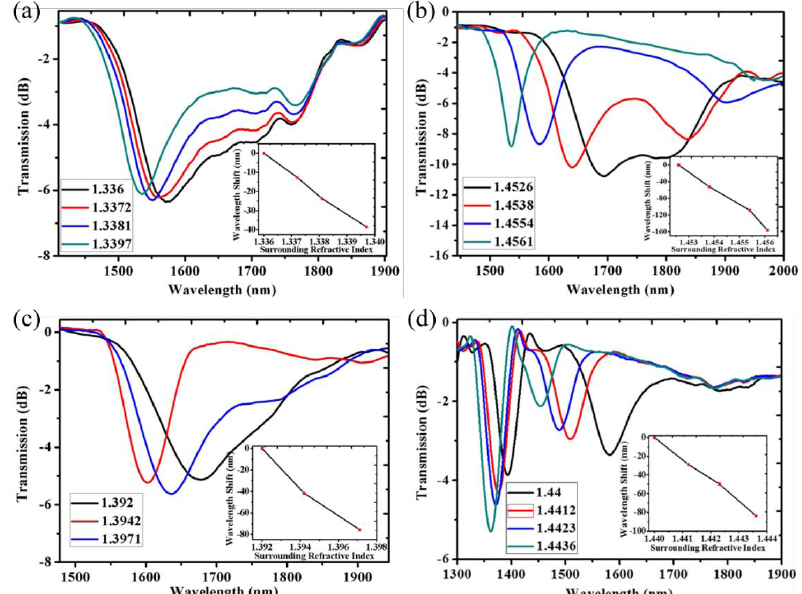
Figure 8. Transmission spectra and resonance wavelength shift in different range of SRI. ( a ) 65 nm TiO 2 nanofilm, Λ = 230.5 μm. ( b ) 15 nm TiO 2 nanofilm, Λ = 237 μm. ( c , d ) 50 nm TiO 2 nanofilm, Λ = 230 μm. Adopted from [61]. Under a Creative Commons license .